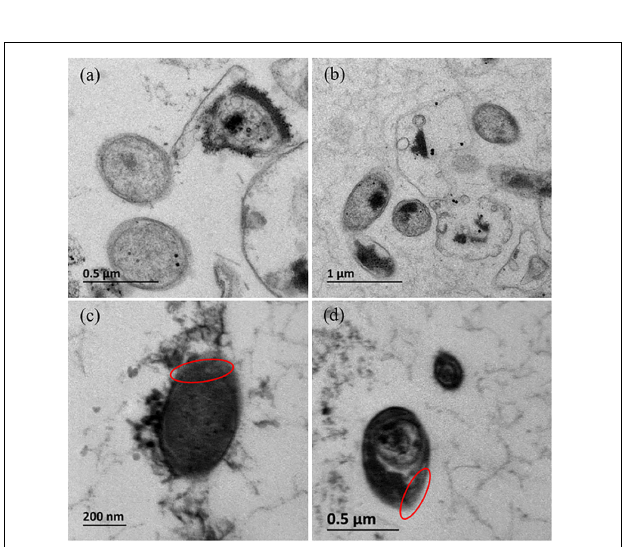
FIGURE 3 | The cellular morphology of Dhc 195 (TEM) without FeS (a,b) and with FeS (c,d)